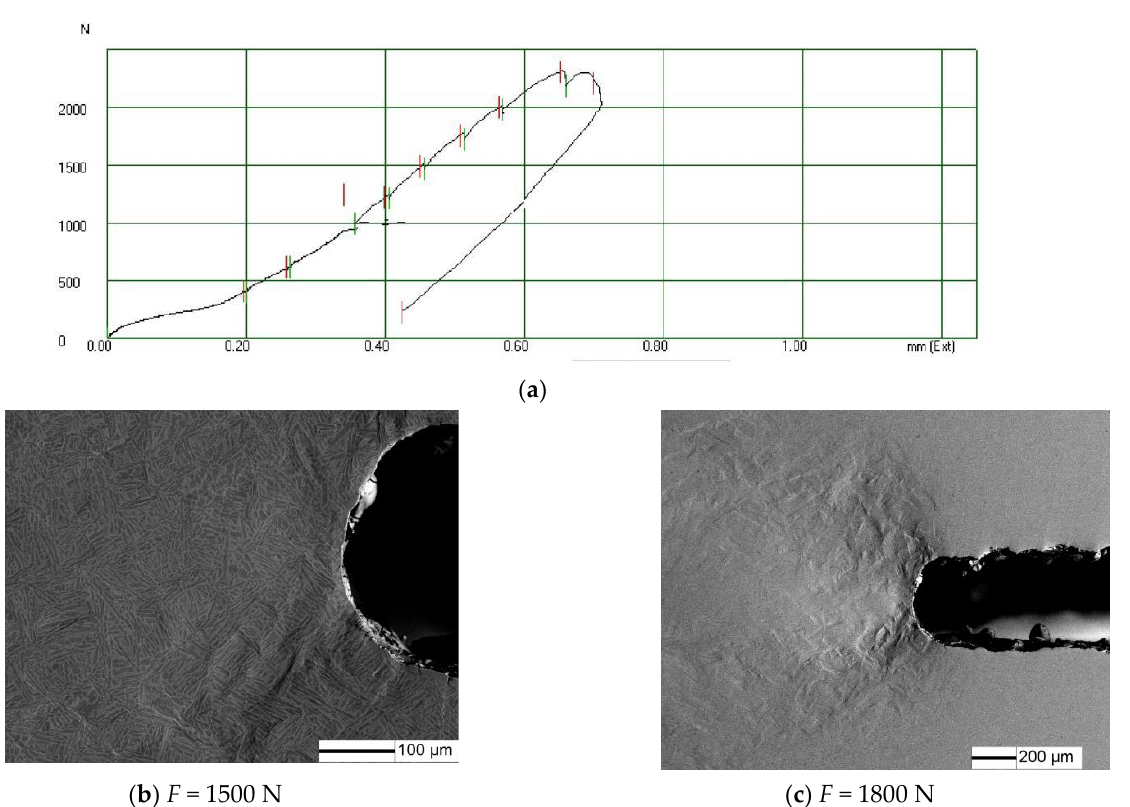
Figure 5. Tensile curve and deformation morphology of in-situ fatigue specimen: ( a ) curve of tensile load-displacement; ( b ) deformation morphology of notch root under 1500 N loads; F = 1500 N. ( c ) deformation morphology of notch root under 1800 N loads. F = 1800